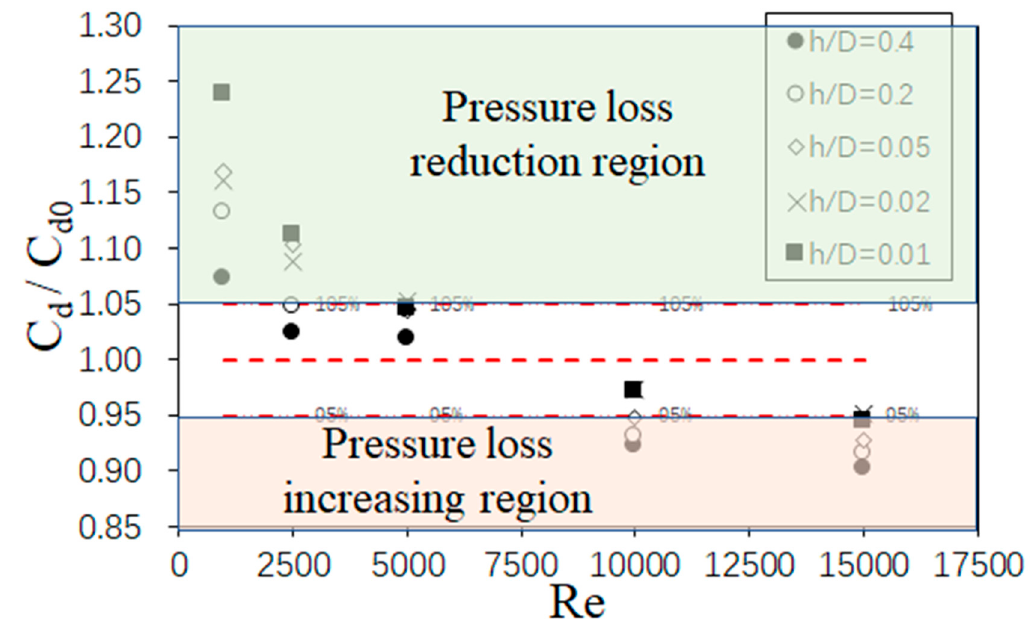
Figure 11. Discharge coefficient ratio as dependent upon Re j ranging from 0 to 15,000 for different micro cooling units heights.